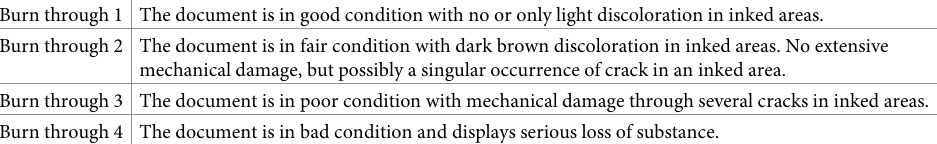
Table 1. Categories of burn through. Burn through 1 The document is in good condition with no or only light discoloration in inked areas. Burn through 2 The document is in fair condition with dark brown discoloration in inked areas. No extensive mechanical damage, but possibly a singular occurrence of crack in an inked area. Burn through 3 The document is in poor condition with mechanical damage through several cracks in inked areas. Burn through 4 The document is in bad condition and displays serious loss of substance. Degree of ink corrosion evaluated through categories of burn through; categories generally defined according to Reißland and Hofenk de Graaff [22].